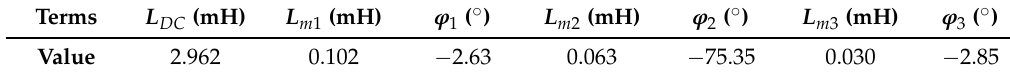
Table 5. Amplitude and phase angle of main harmonic components.